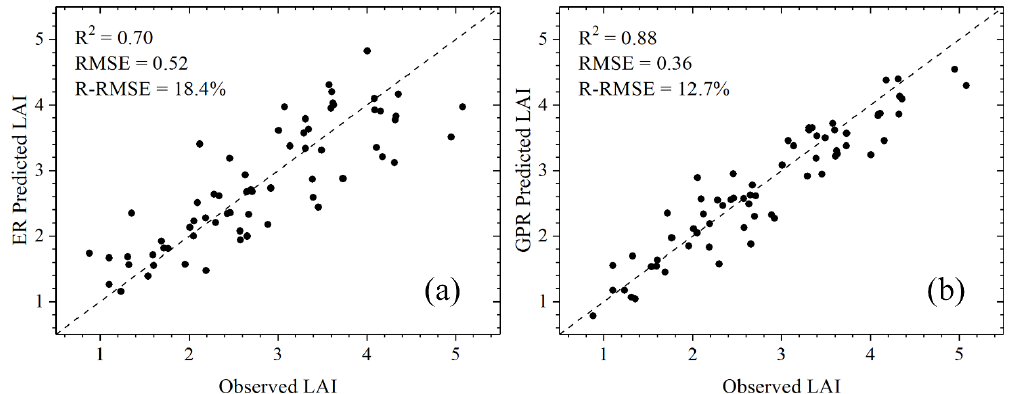
Figure 6. Cross-validation of ( a ) exponential regression (ER) predicted LAI, and ( b ) Gaussian process regression (GPR) with field LAI observations. The dashed line represents the 1:1 line.